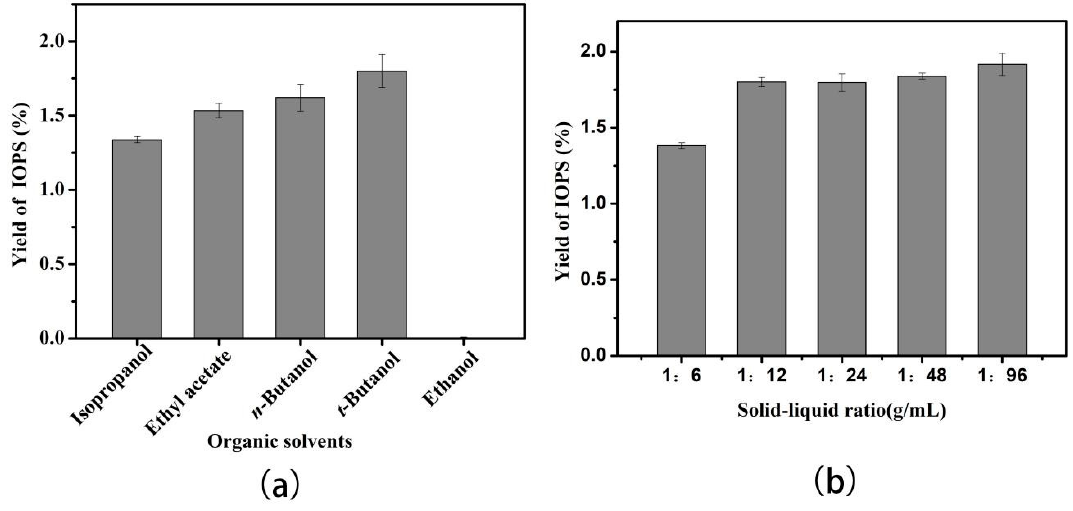
Figure 1. Effect of ( a ) different kinds of organic solvents on the extraction yield (EY) of IOPS using a solid-liquid ratio of 1:12, 30% mass fraction of (NH 4 ) 2 SO 4 ( w/v ), organic solvent (10 mL), an extraction time of 30 min, and a temperature of 30 °C at pH 8.0; ( b ) solid-liquid ratio on the EY of IOPS using a mass fraction of (NH 4 ) 2 SO 4 30% ( w/v ), t -butanol (10 mL), an extraction time of 30 min, and a temperature of 30 °C at pH 8.0.